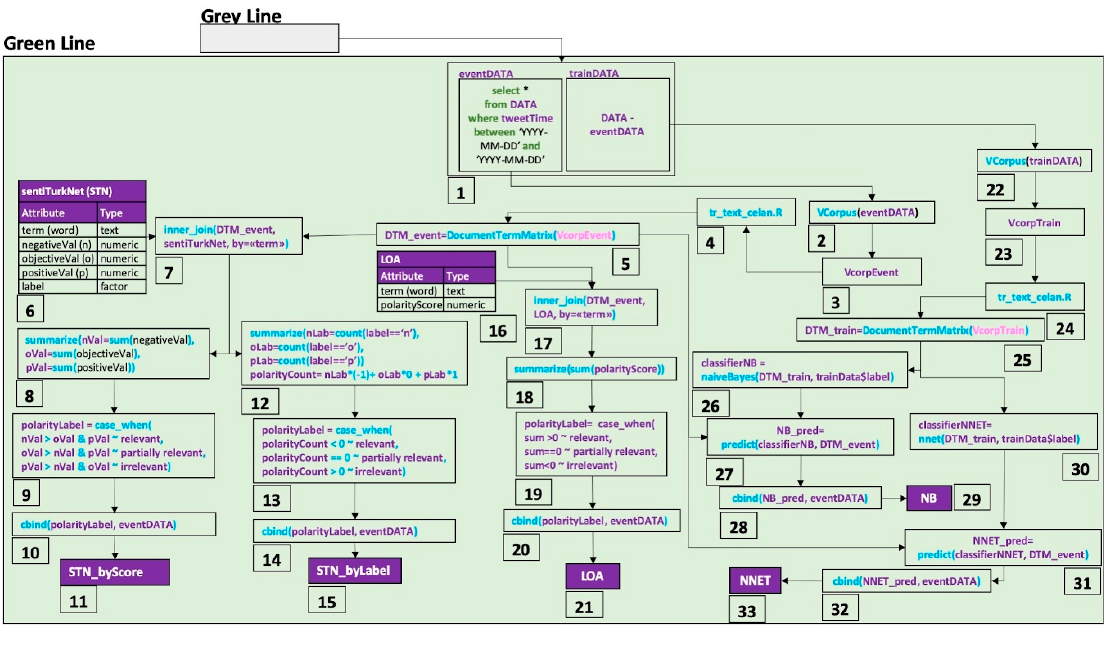
Figure 4. Green line for data processing.